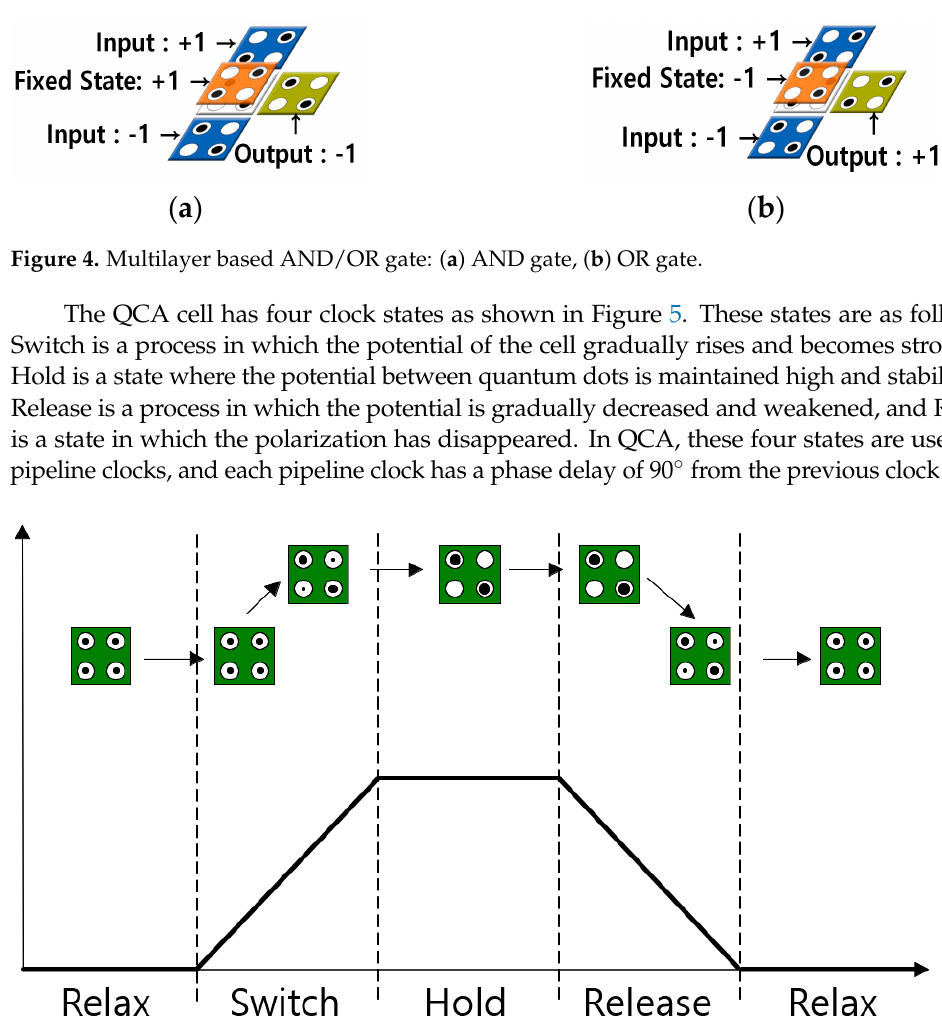
( b ) Figure 3. Signal transmission in multi-layer: ( a ) Grid expression of vertical transmission; ( b ) Grid expression of diagonal transmission.